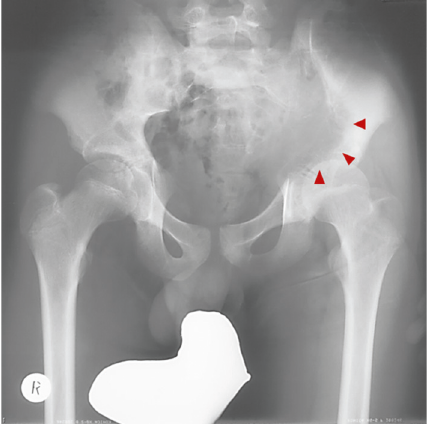
Figure 1: Plain radiograph showing osteolytic changes at the medial side of the left iliac bone.